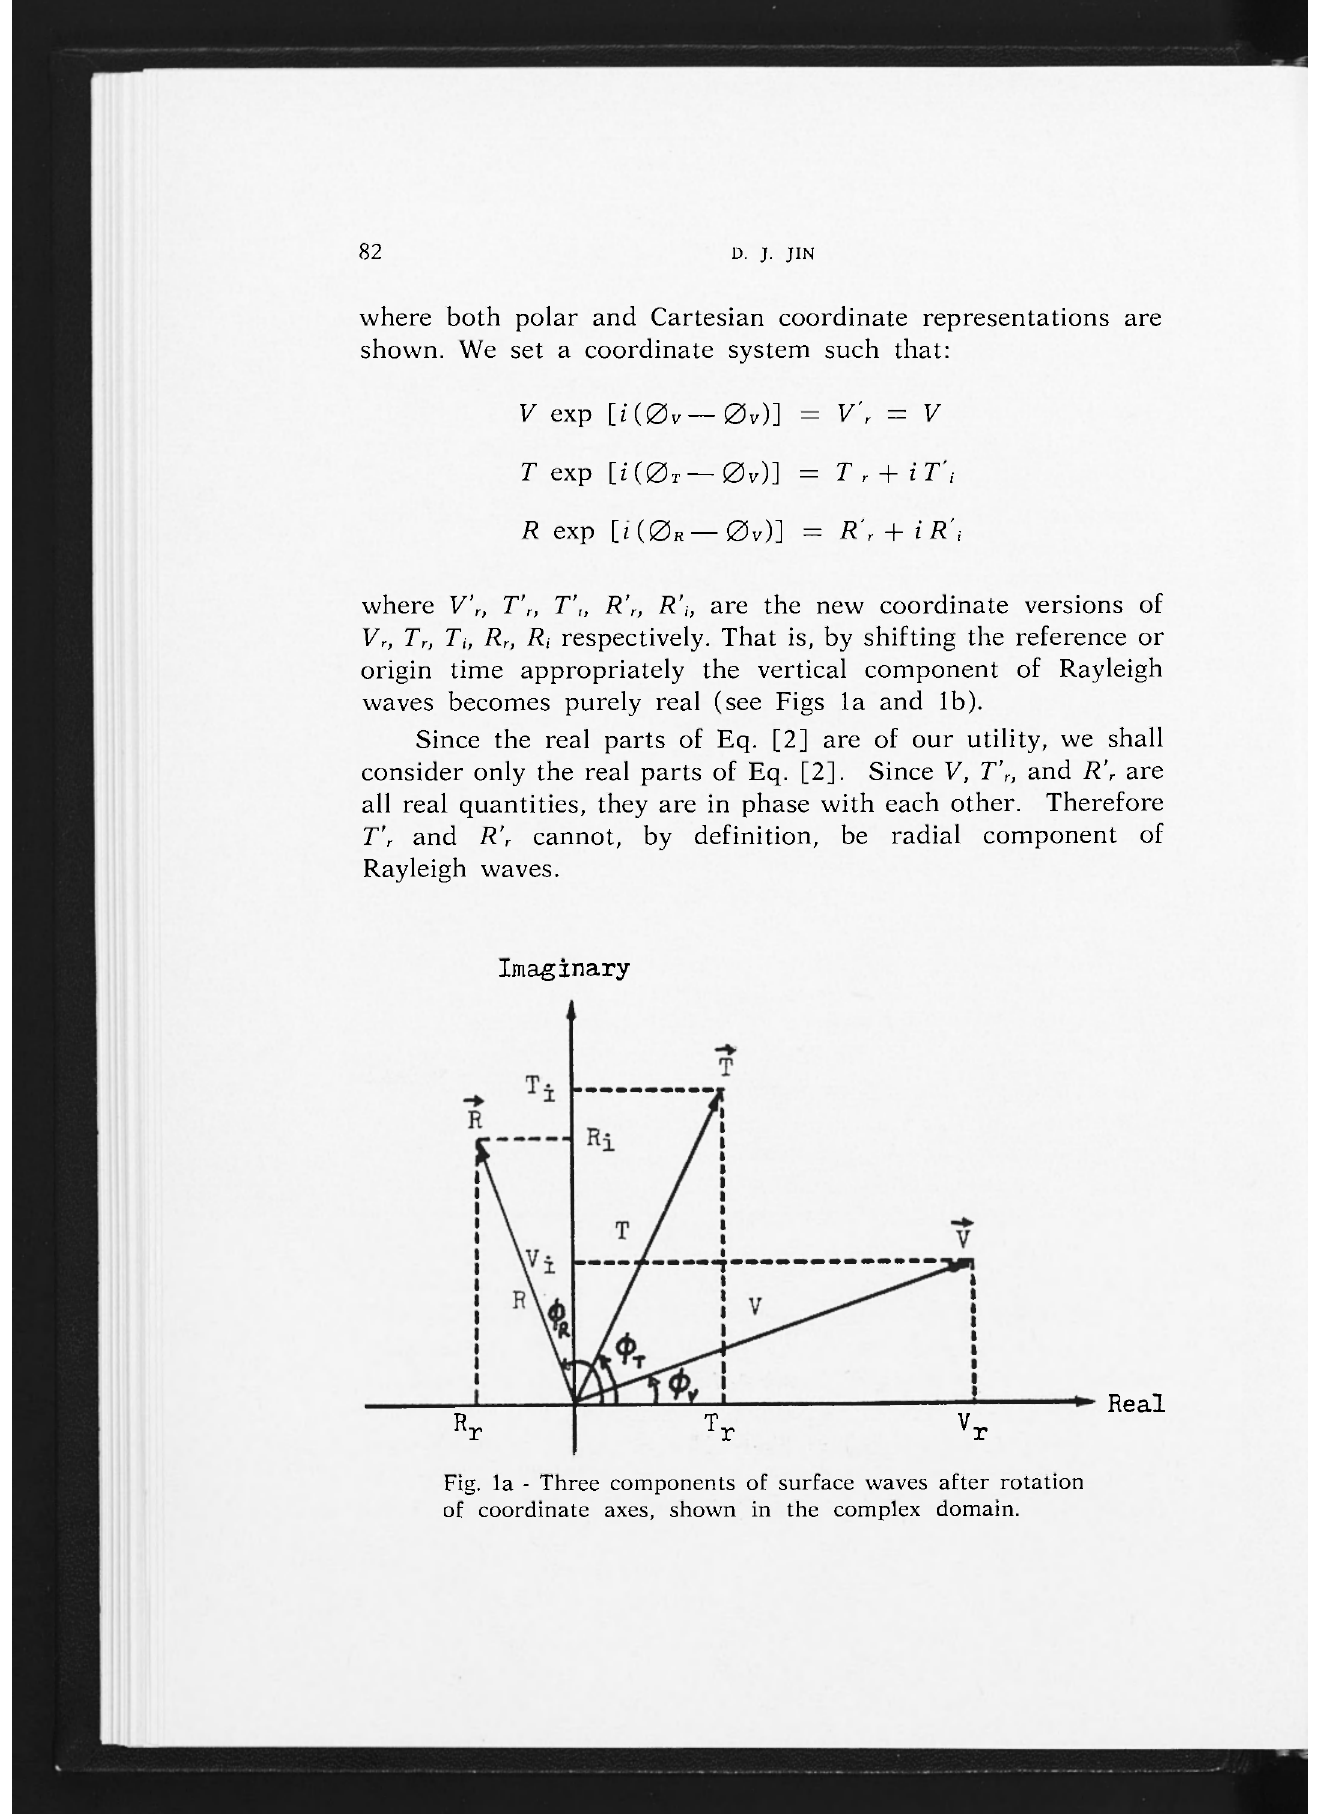
Fig. la - Three components of surface waves after rotation of coordinate axes, shown in the complex